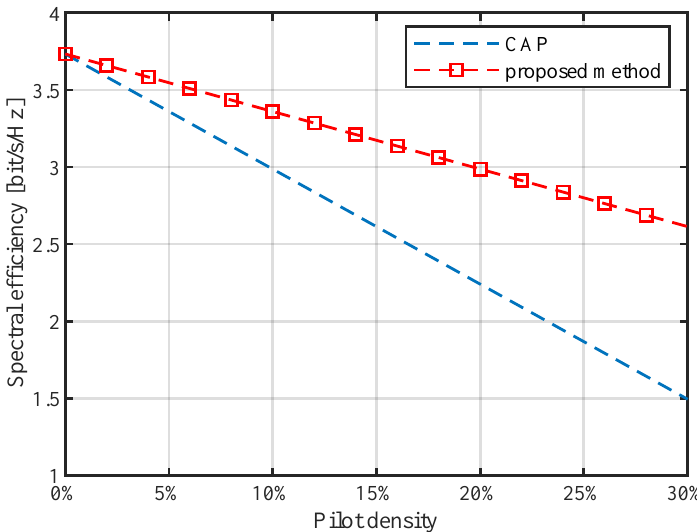
Figure 5. Spectral efficiency when the 16QAM and frame structures in Figure 4 are adopted.